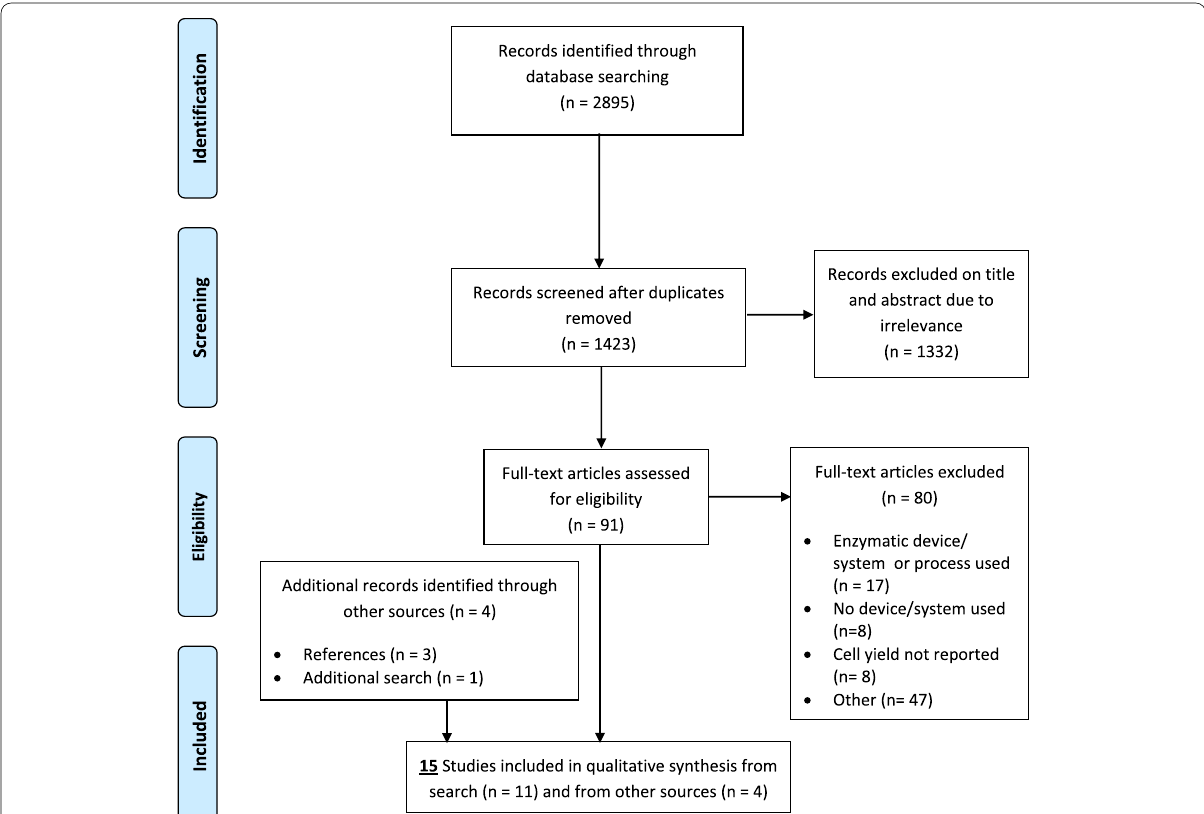
Fig. 2 PRISMA flow diagram for search results (adapted from Moher et al